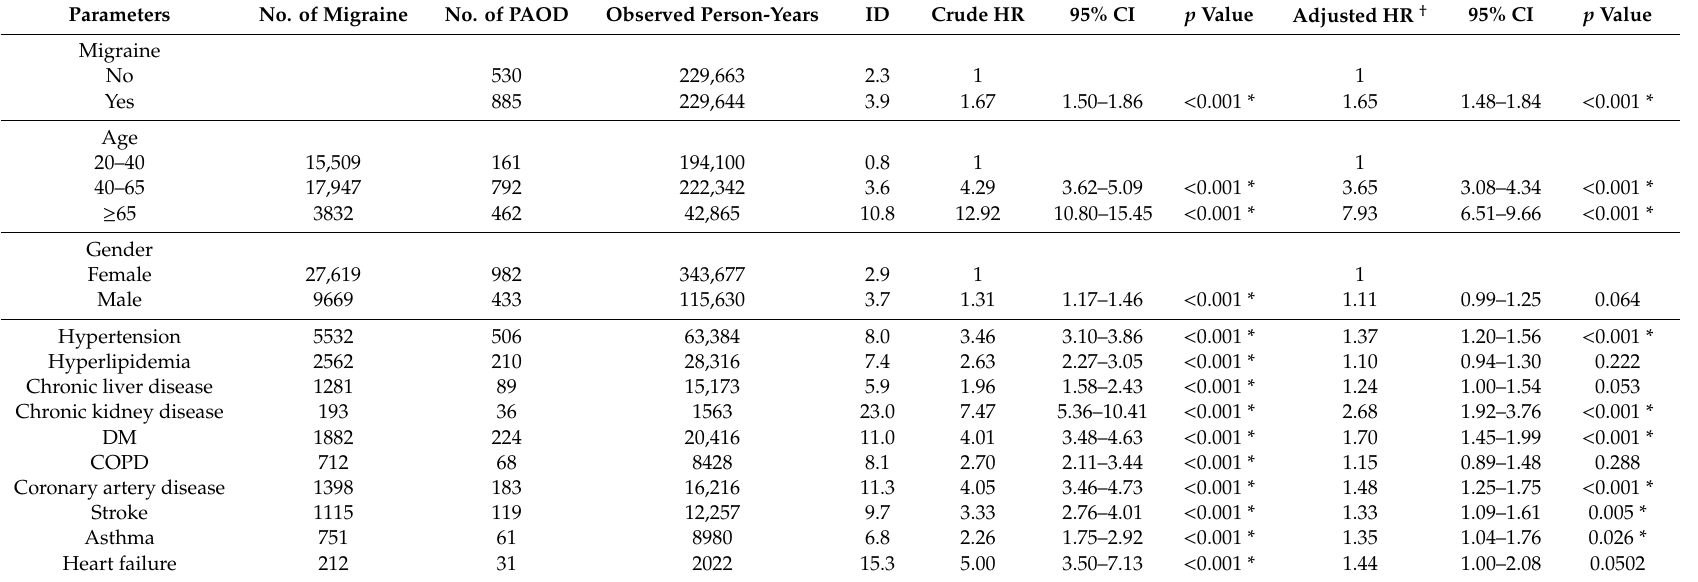
Table 2. Risk of peripheral artery occlusive disease between migraine and non-migraine group in Cox proportional hazard